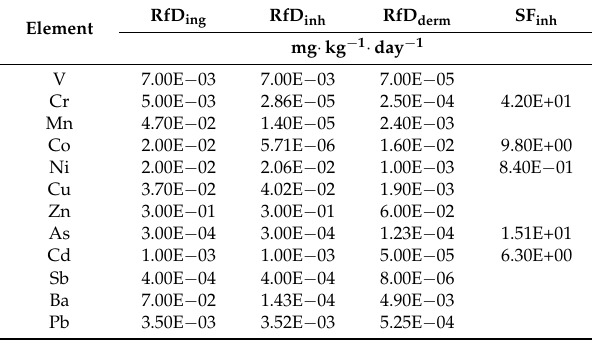
Table 1. The reference doses (RfDs) of potentially toxic elements via ingestion, inhalation through mouth and nose, and dermal contact and slope factors (SF inh ) of Cr, Co, Ni, As, and Cd via inhalation in this study [33,34,36,37,40]. RfD ing Element